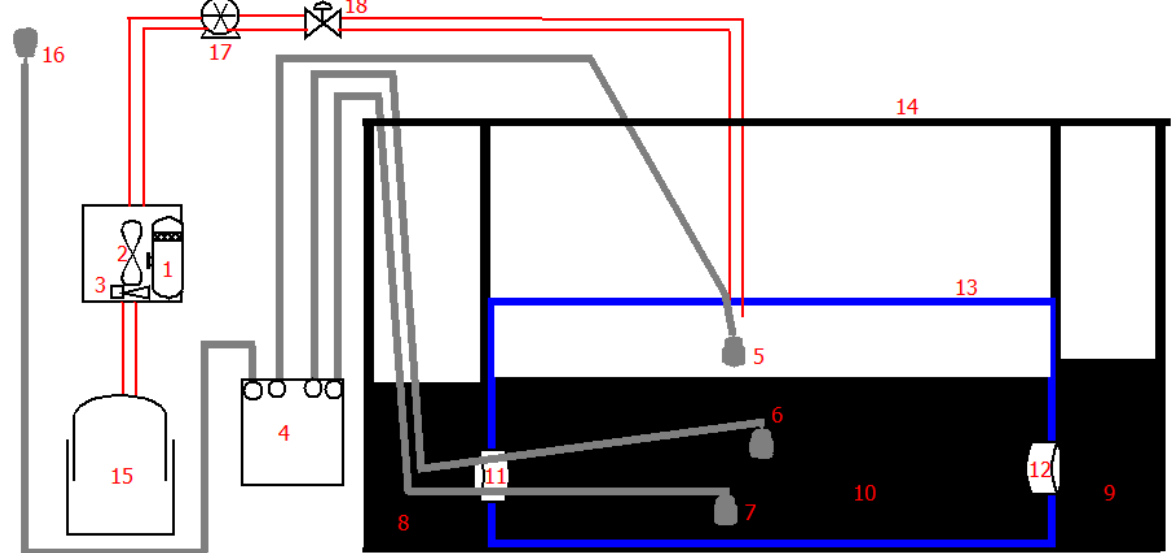
Figure 1. Designed layout of constructed balloon digester with the data acquisition